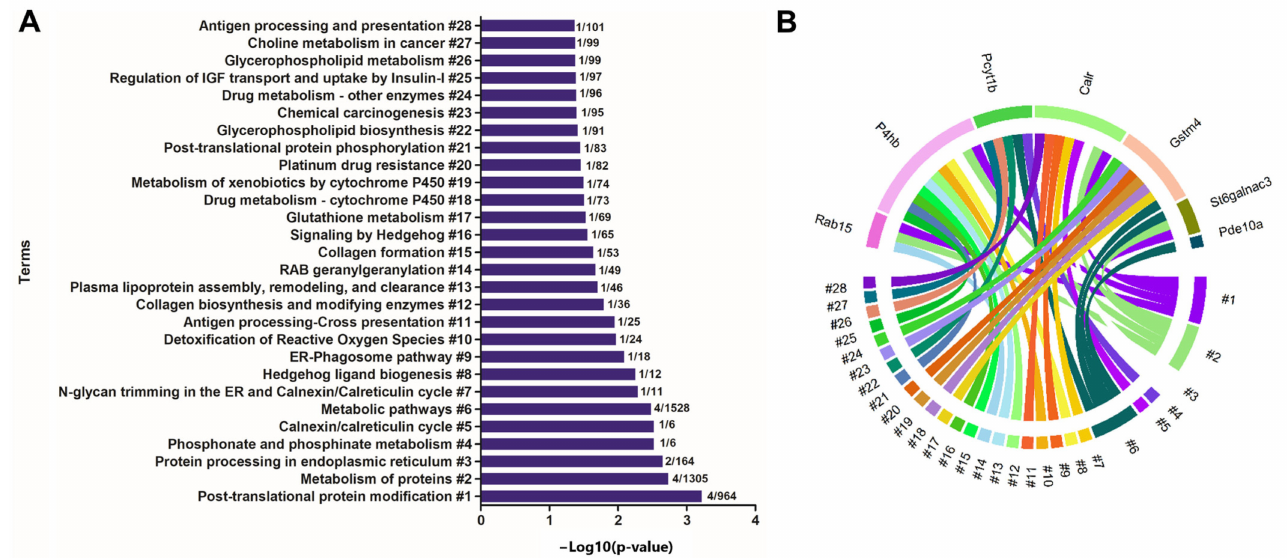
Figure 3. ( A ) Ontological enrichment terms by KOBAs 3.0. All data were expressed as − Log 10 ( p -value). The numbers in the bar graph identify the input number of predicted targets that enriched each term. ( B ) Circus plot graphic identifying the association of deregulated targets involved in each enriched